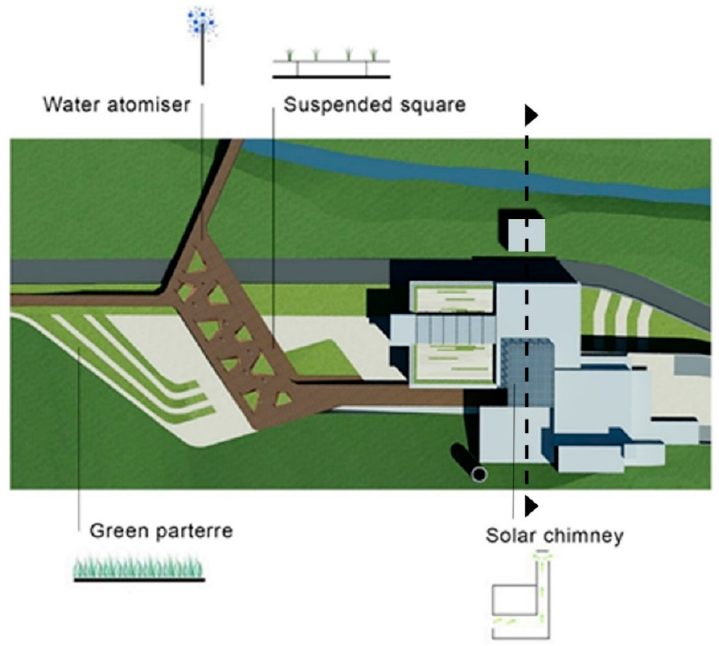
Figure 13. Case study no. 2, Ex S.I.M.E.